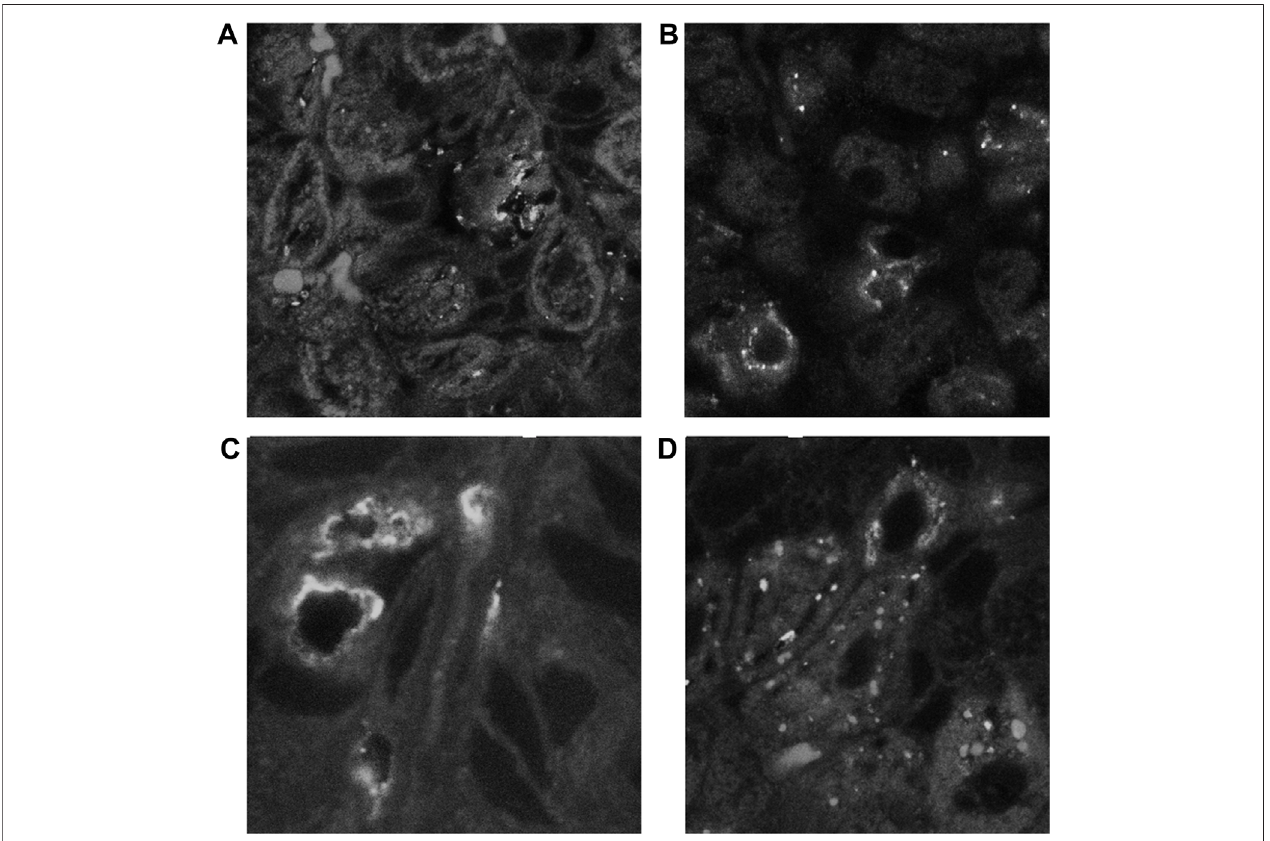
FIGURE 5 | Alteration of NHPH localization in the fundic gland in the infection group by acid suppressants by indirect fl uorescent immunohistochemistry using an anti-HsvA antibody. (A) In the infection-alone group, linear-shaped NHPHs were mostly found within the intracellular canaliculi of the parietal cells and in the gastric glandular lumen, X 400. (B) In the famotidine-treated mice, many spiral-shaped NHPHs were seen in the intracellular canaliculi of the parietal cells and in the gastric glandularlumen,X400. (C) Inthelansoprazole-treatedmice,manyspiral-shapedNHPHswereseenintheenlargedintracellularcanaliculusoftheparietalcellsand in thegastric glandular lumen, X 600. (D) In thevonoprazan-treated mice,the round-shapedNHPHs weremostlyseen inthe intracellular canaliculus ofthe parietal cells, X